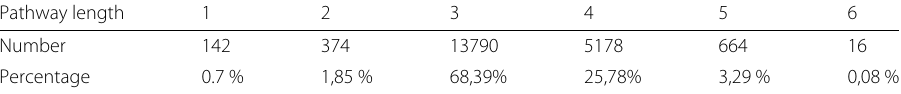
Table 10 Numbers and lengths of shortest paths between pairs of private proteins Pathway length 1 2 3 4 5 6 Number 142 374 13790 5178 664 16 Percentage 0.7 % 1,85 % 68,39% 25,78% 3,29 % 0,08 %